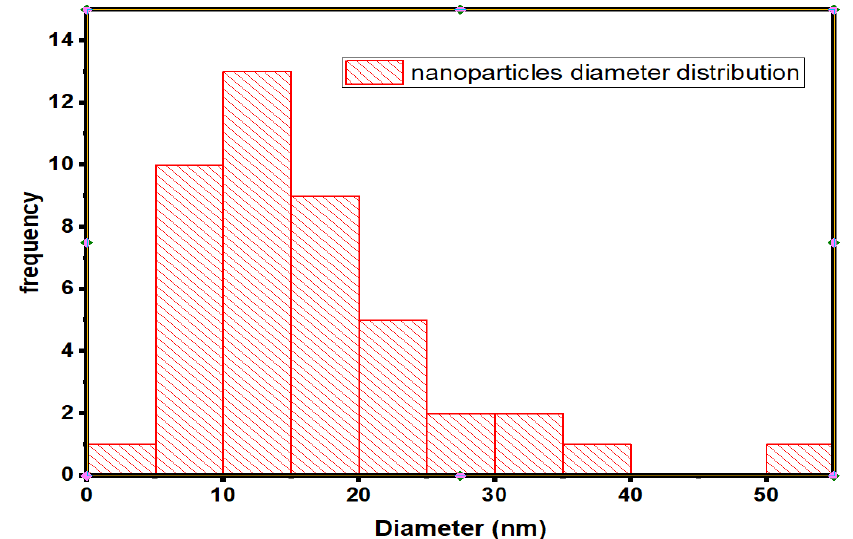
Figure 5. Histogram for nanoparticle diameter distribution.